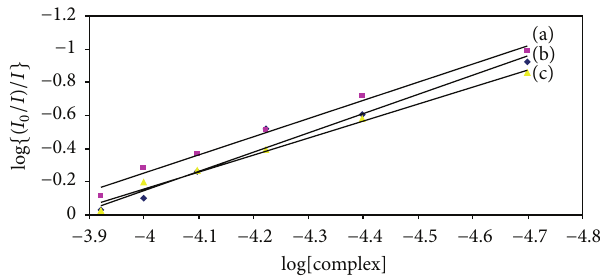
Figure4:Scatchardplotoffluorescencetitrationof(a)CuL,(b)NiL, and (c) ZnL with CT